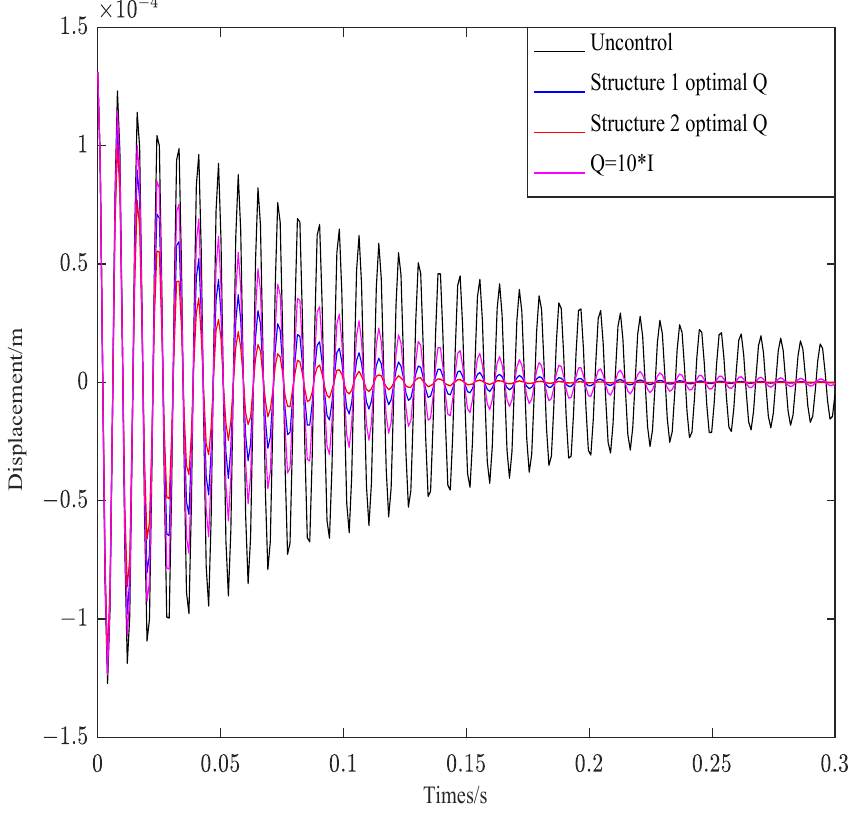
Figure 7. Effect of parameter Q on structure 1.